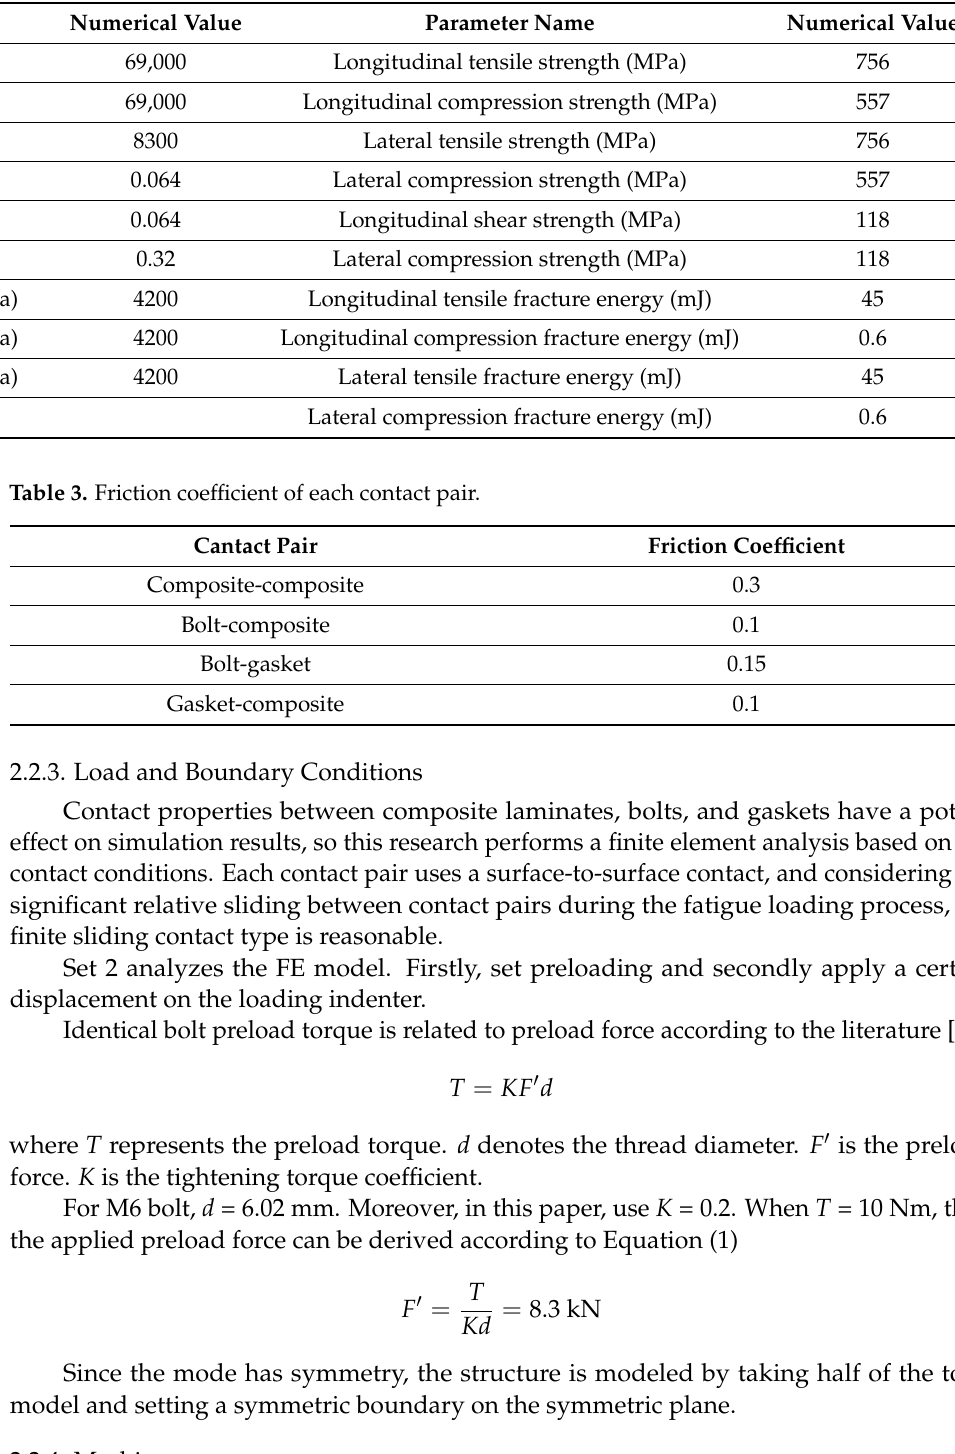
Table 2. Material properties of T300BZ-3234 (Unit: N-s-MPa-mJ).